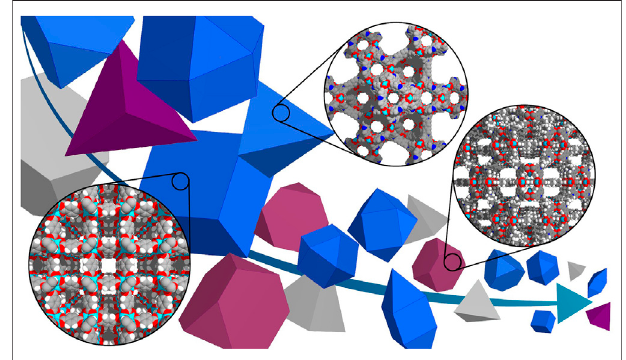
FIGURE 1 | The size and morphology of framework materials may substantially impact macroscopic